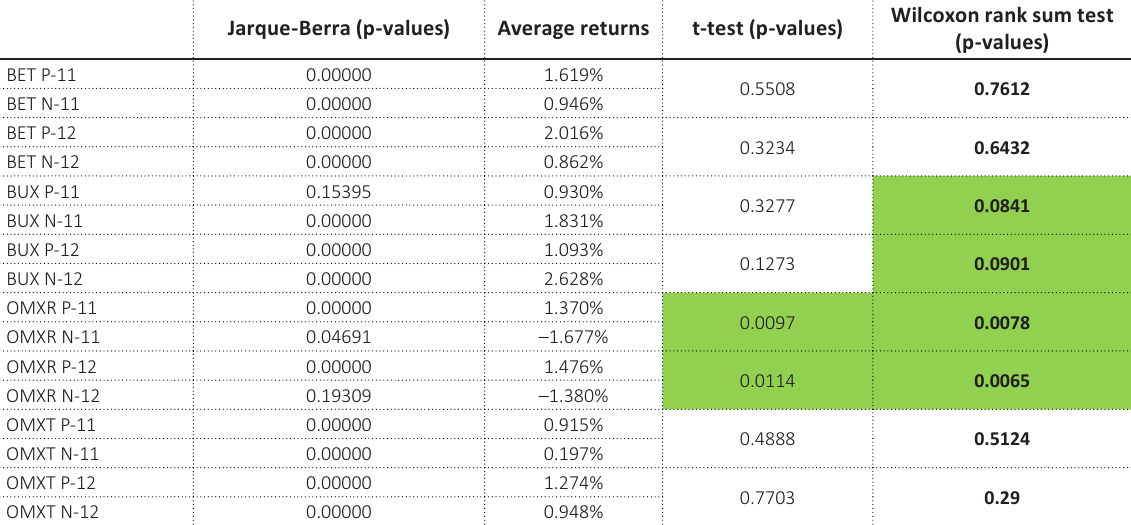
Table 6. January barometer statistical significance test results (monthly